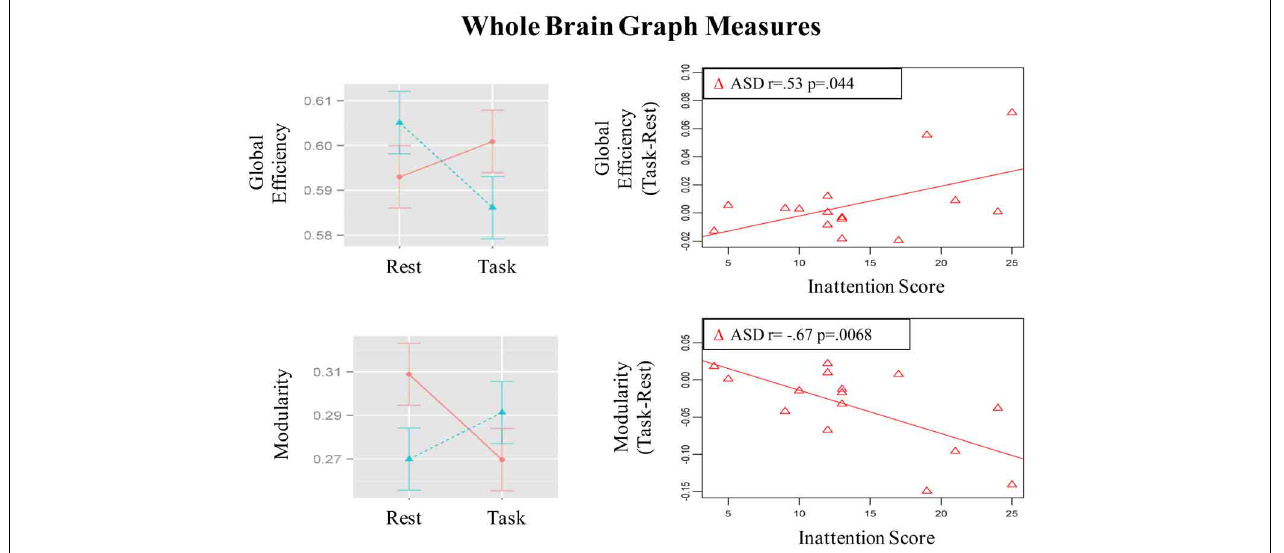
FIGURE 5 | Graphs depicting Group x State interaction for graph theory measures and correlation of the magnitude of state-related change (Task-Rest) with inattention scores in the ASD group.